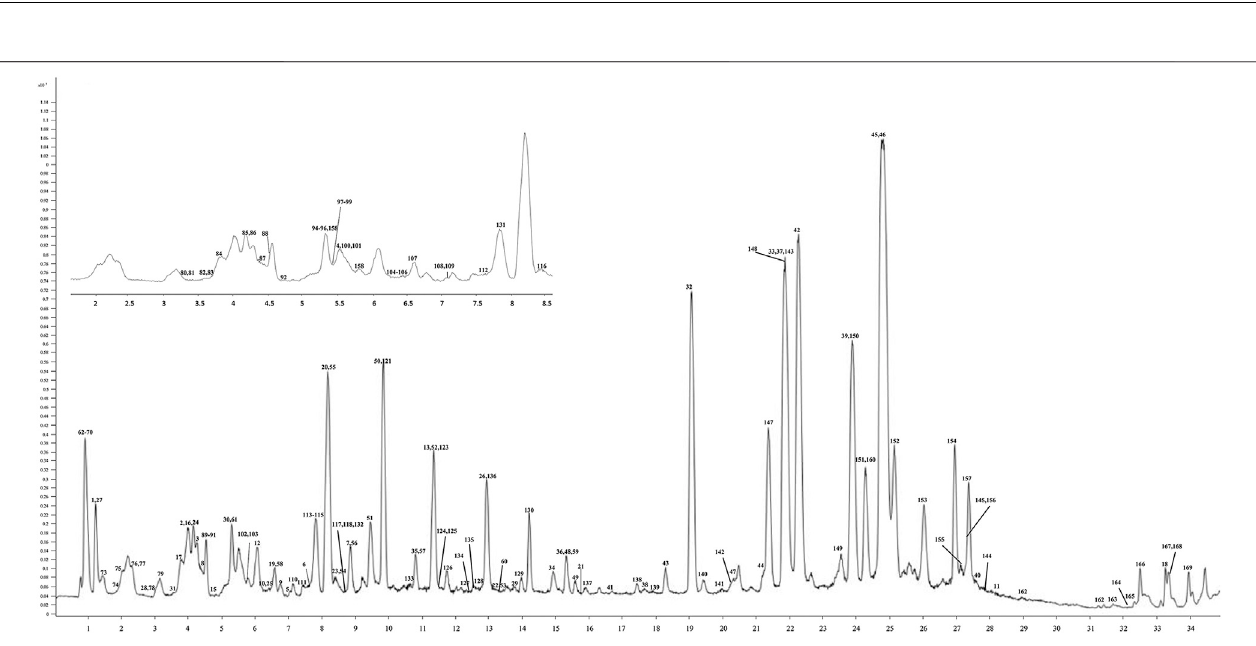
FIGURE 4 | UHPLC-Q/TOF-MS chromatogram of the P. chinense extract used in the trial. The X -axis is the retention time, and the Y -axis is the absorbance unit.